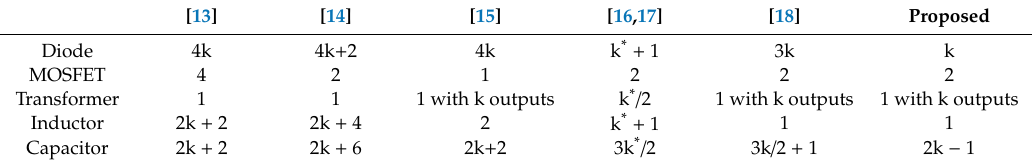
Table 1. Comparison of the number of required components for k LED strings using resonant converters.